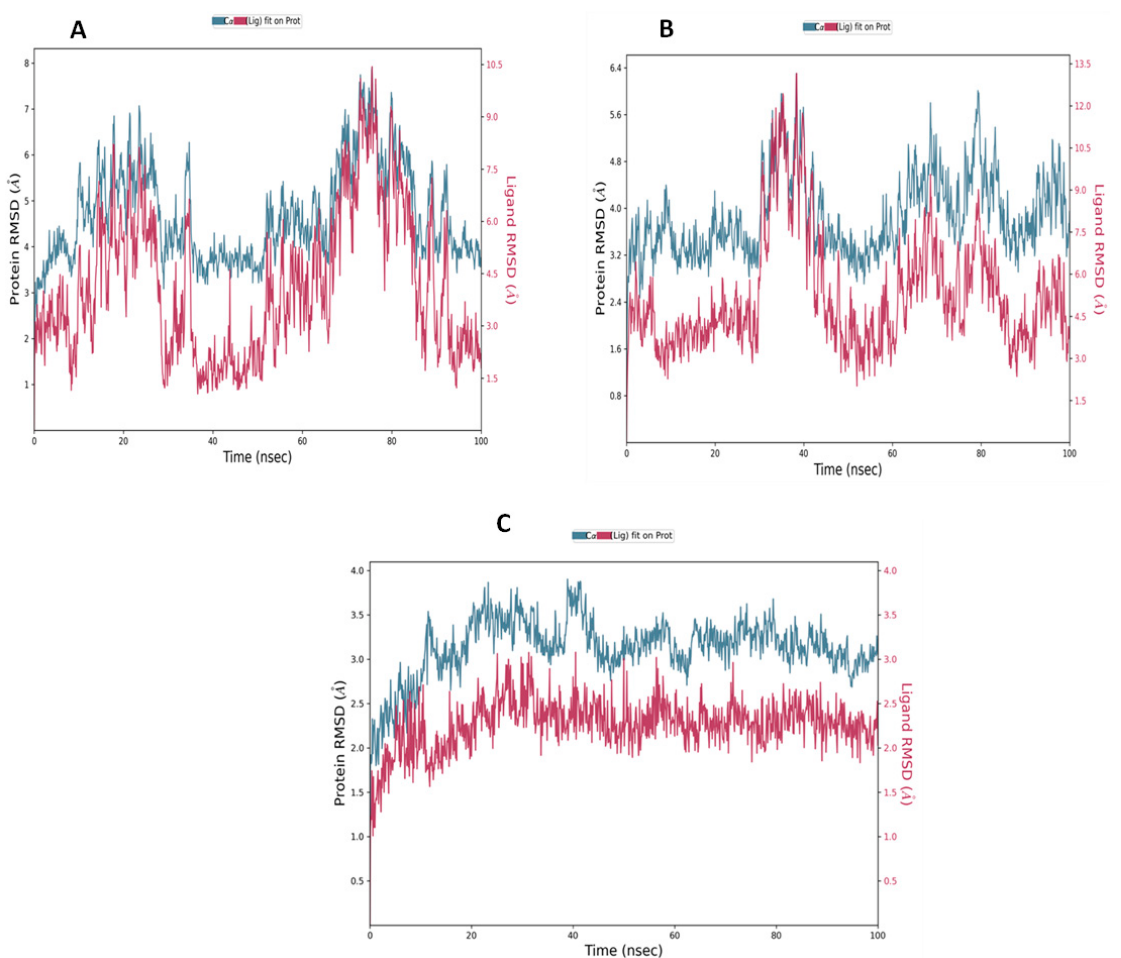
Figure 11. RMSD plot for ( A ) native agonist (PDB ID: E3R); ( B ) boremexin C ( 161 ); ( C ) garcinisidone E ( 215 ) with CB2 receptor (PDB ID: 6KPF) during the MD simulation. Figure 12A represents a scheme of the binding interactions of the native agonist (PDB ID: E3R ) and the amino acid residues of the CB2 receptor (PDB ID: 6KPF). Throughout the simulation, docked positions were maintained. The native agonist interacted through a hydrogen bond with Ser285, which was maintained for over 90% of the simulation time (100.00 ns), as well as a pi–pi stacking interaction with Phe87 (90%). Other interac- tions included a pi–pi stacking interaction with Phe183 (77%) and a hydrogen bond with Leu182 (40%). The interactions are also presented as stacked bars and categorized into three types: hydrogen bonds, hydrophobic interactions, and water bridges (Figure 12B). The major contacts between the ligand and the CB2 receptor included hydrophobic in- teractions with Phe87 and Phe183 for over 80% of the trajectory time. The protein–ligand interactions also included hydrogen bonding interactions with Ser285 and Leu182, which were maintained for over 90% of the simulation.